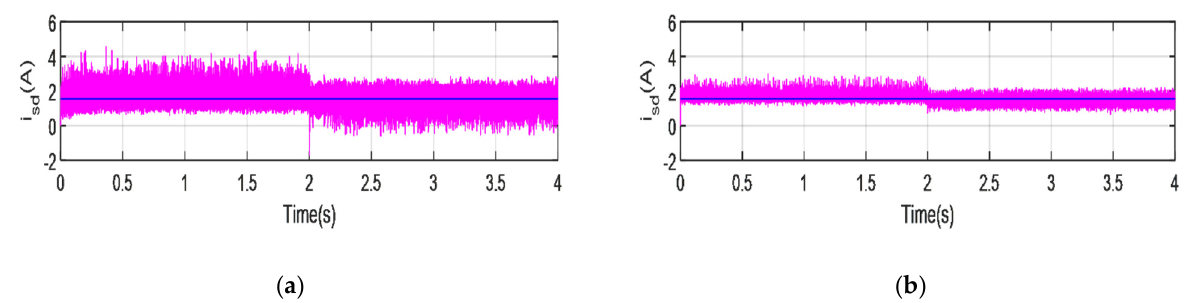
Figure 11. Isd components: ( a ) conventional inverter; ( b ) five-level inverter.